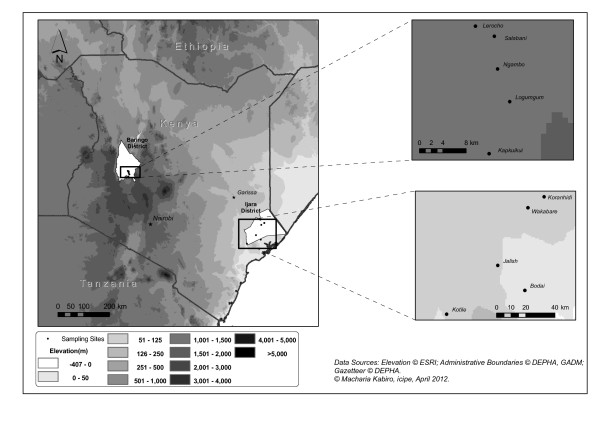
Mapping showing trapping sites in Kenya.